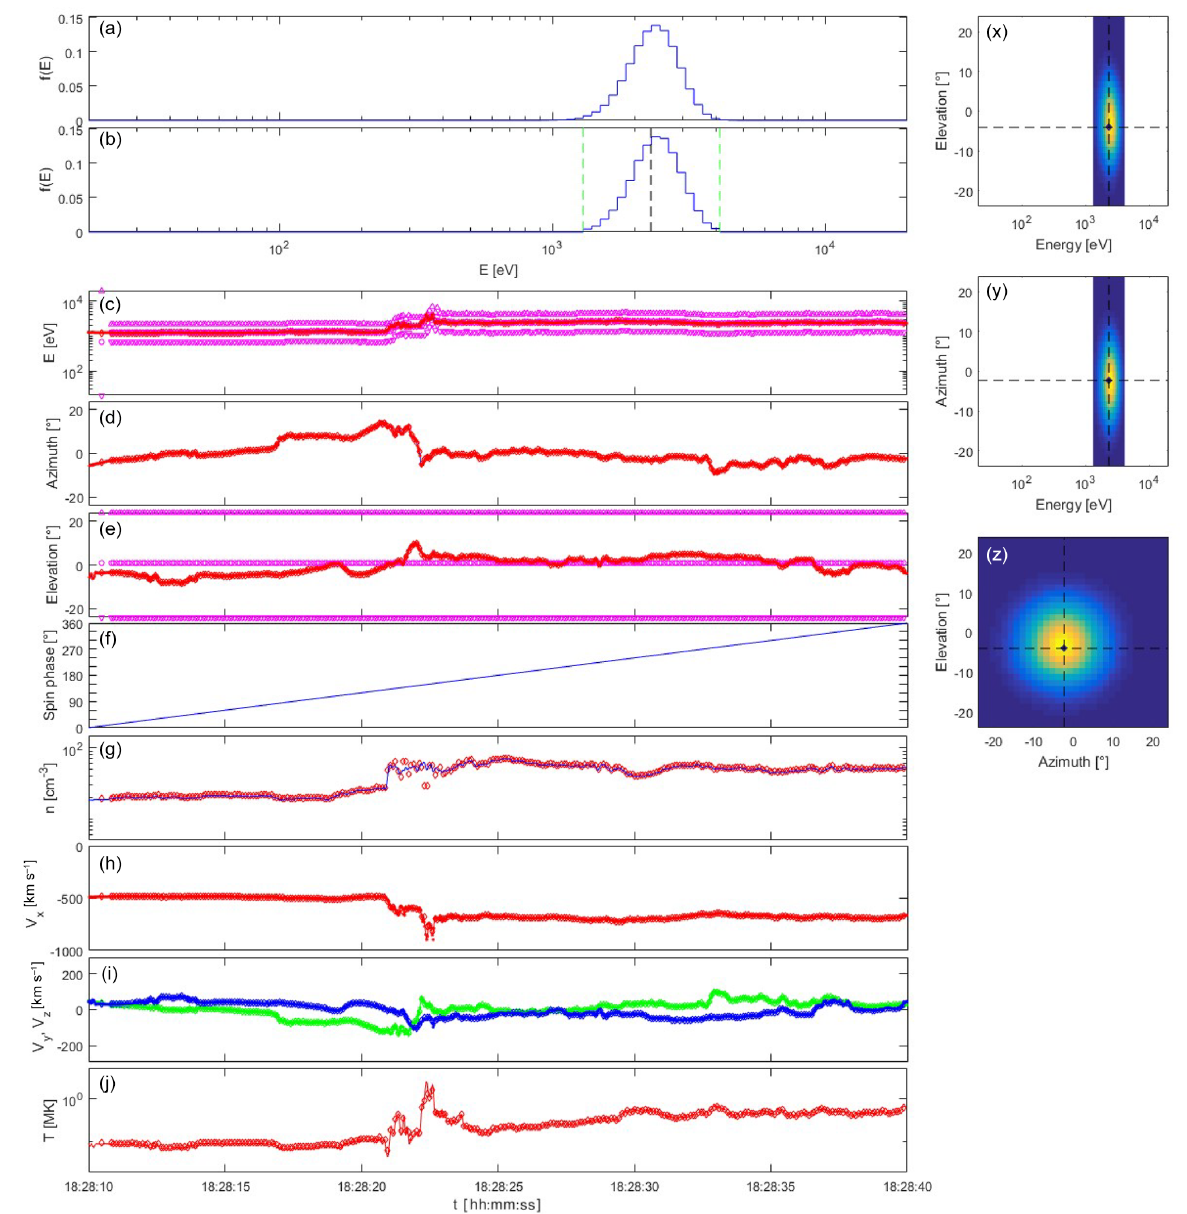
Figure 9. Plasma spectrometer measurements for a solar wind simulation with the same data as Fig. 8, using external energy beam tracking with a delay of 30ms. The plot layout is the